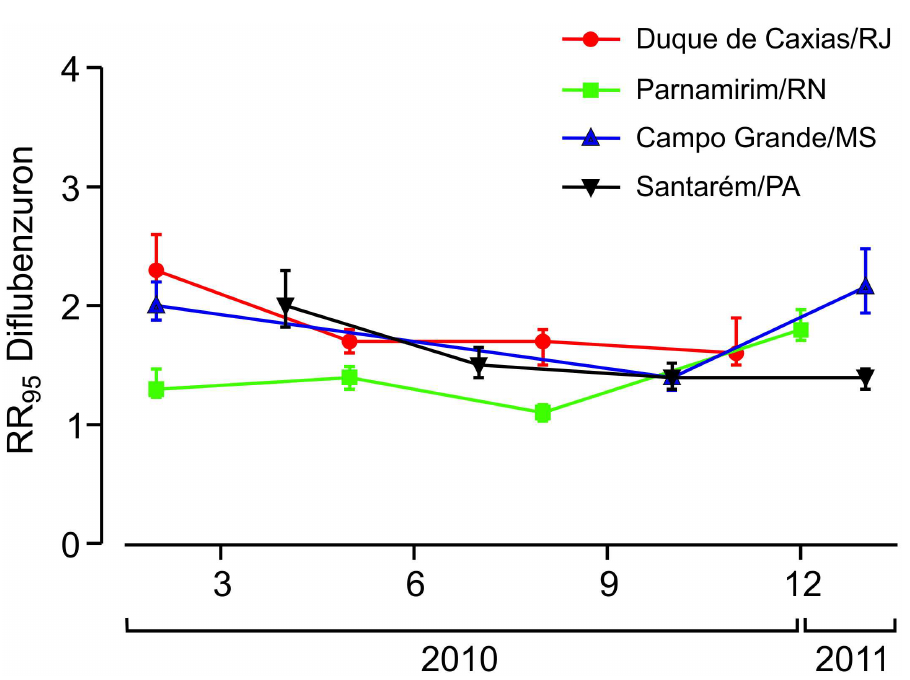
Fig 3. Temporal evaluation of diflubenzuron susceptibility status of four Brazilian Ae . aegypti populations. Each point indicates the Resistance Ratio (RR 95 ) and the 95% confidence interval.